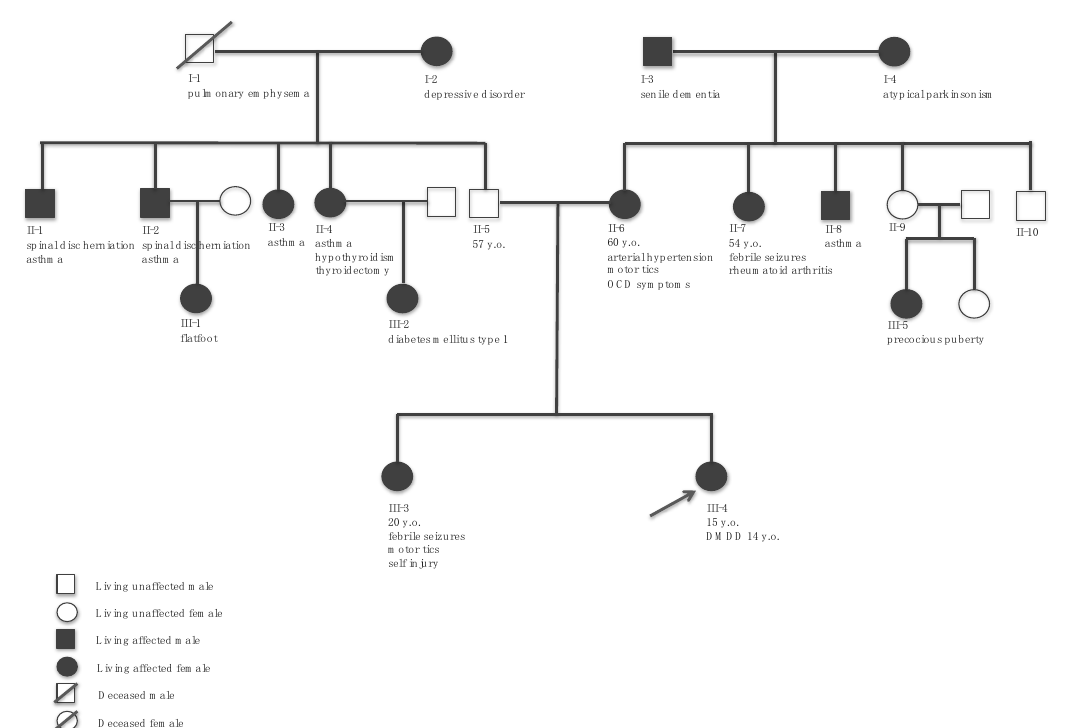
Figure 1. Pedigree of the patient. DMDD, disruptive mood dysregulation disorder.